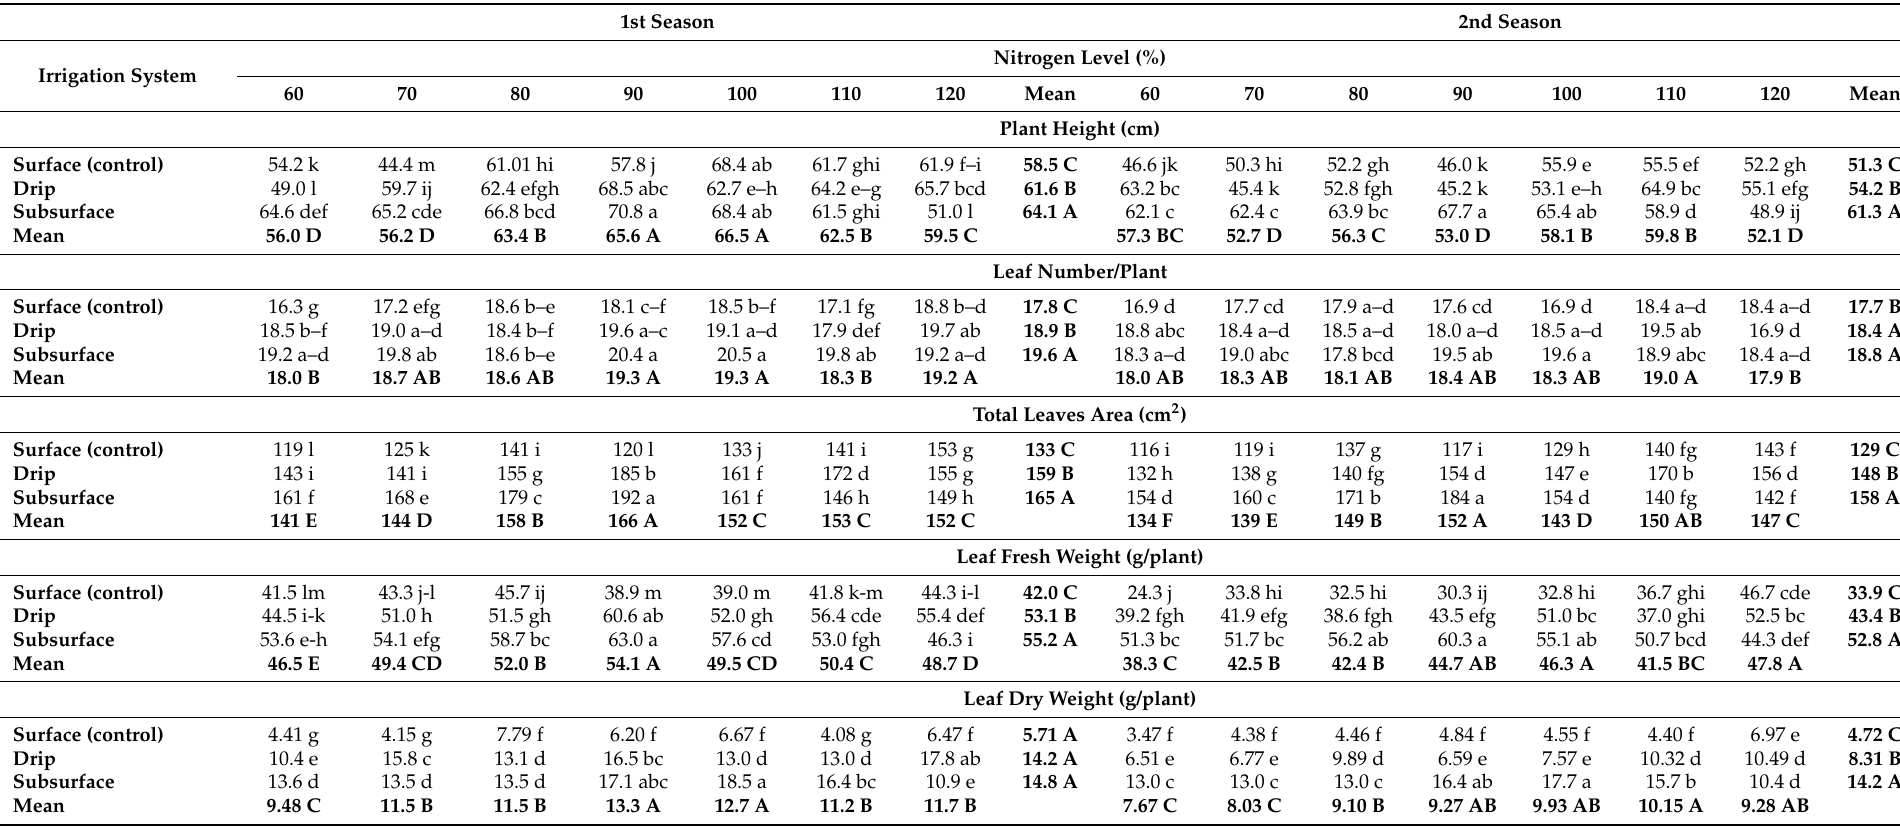
Table 3. Vegetative measurements’ means at different irrigation systems and nitrogen treatments during the studied seasons of 2019 and